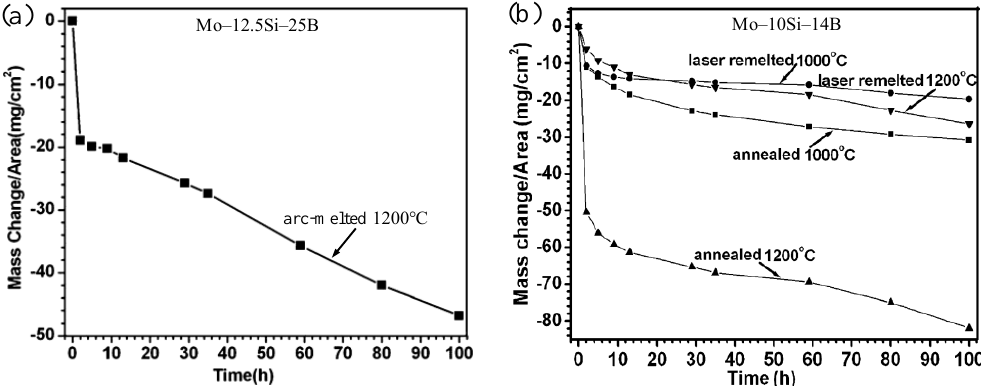
Figure 2. Mass change curves: ( a ) arc-melted alloy cyclic oxidation at 1200 °C, ( b ) laser-remelted and annealed alloys oxidized at 1000 °C and 1200 °C. ( a , b ) reproduced with permission [38,41], respectively. Copyright 2007 Elsevier.